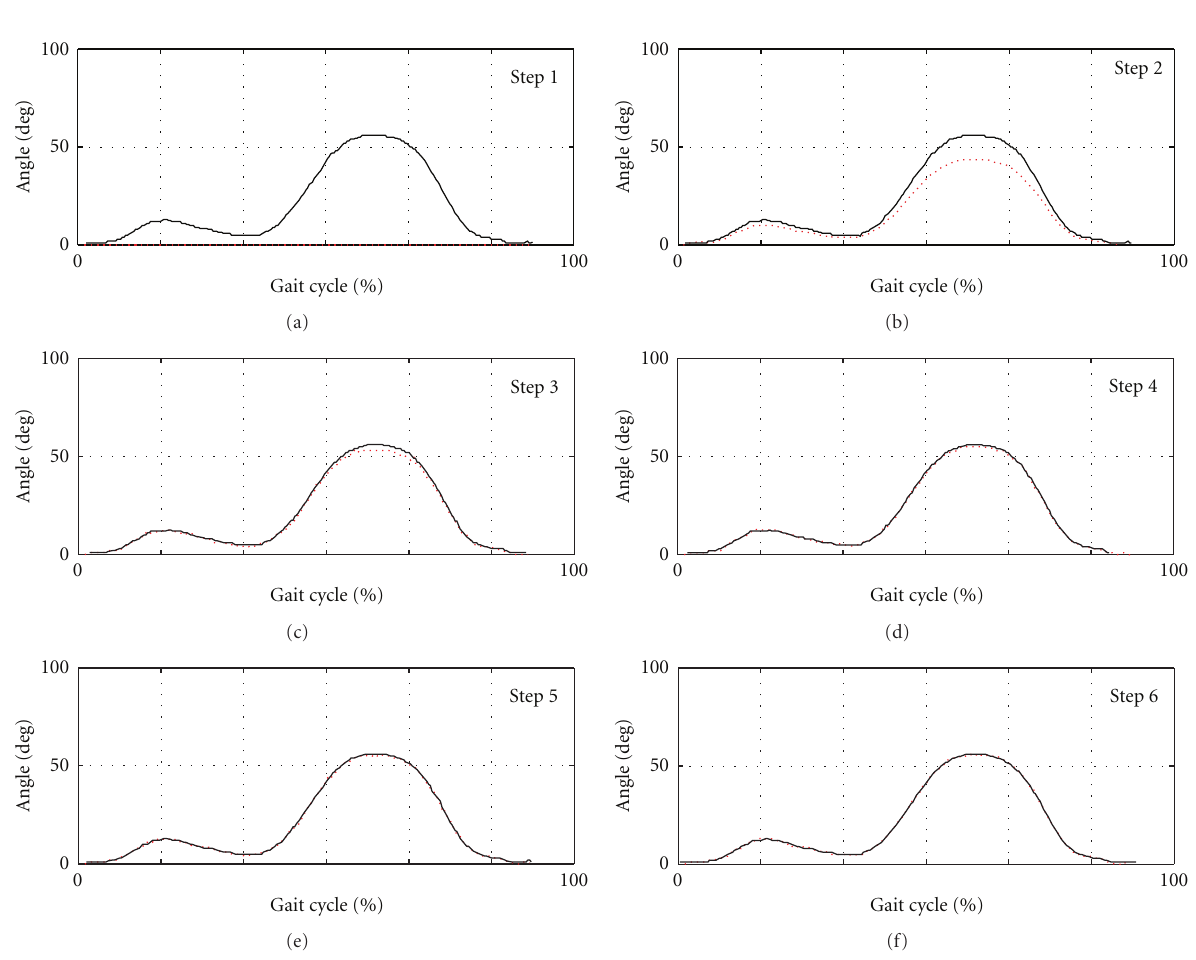
Figure 11: Tracking curve of IBL knee joint relative angle with P-type open/closed-loop